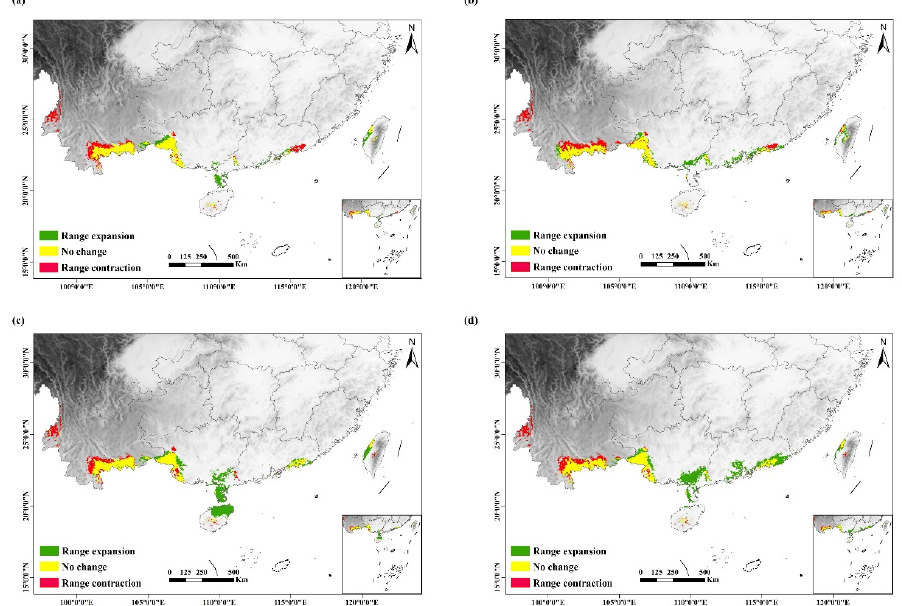
Figure 8. Habitat suitability changes from the current conditions to the future climate (2070s) under climate scenarios in MIROC6 models: ( a ) SSP 2.6, ( b ) SSP 4.5, ( c ) SSP 7.0, and ( d ) SSP 8.5. Green area marks the total expansion of habitat suitability from unsuitable to suitable habitat. Yellow area indicates habitat suitability prediction remained the same. Red area marks the contraction of suitable habitat to